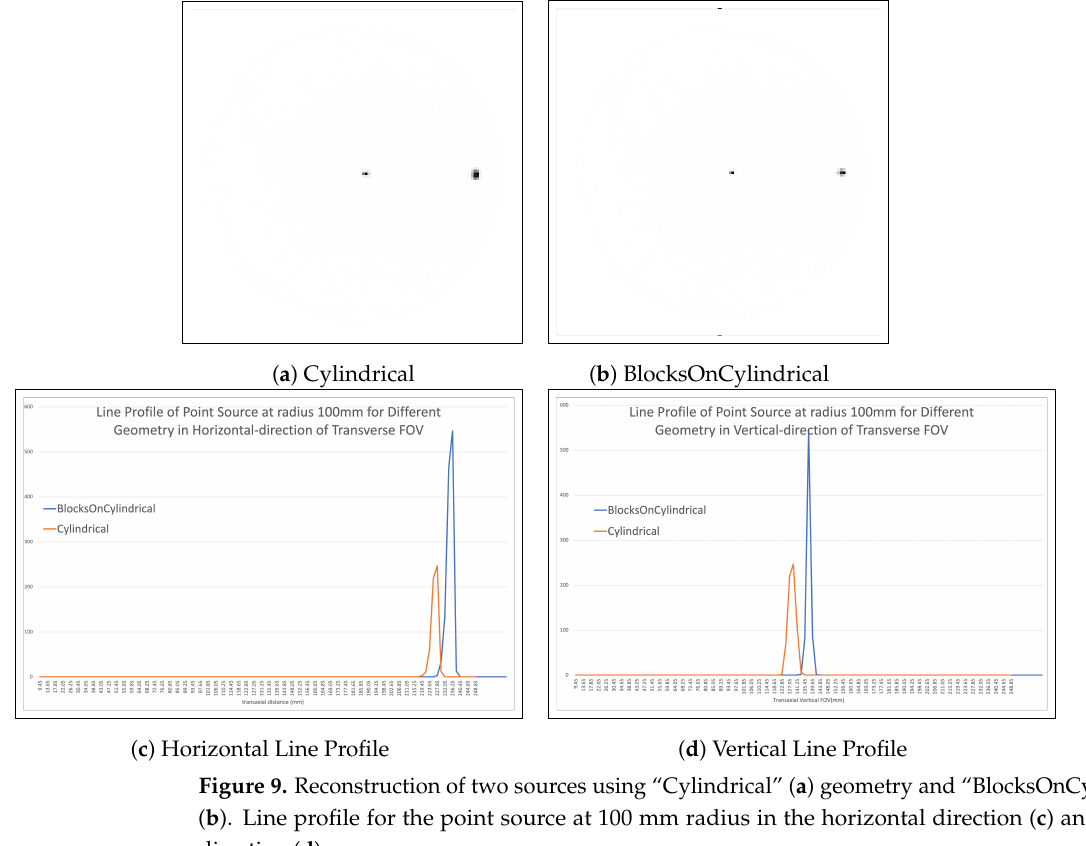
Figure 9. Reconstruction of two sources using “Cylindrical” ( a ) geometry and “BlocksOnCylindrical” ( b ). Line profile for the point source at 100 mm radius in the horizontal direction ( c ) and vertical direction ( d